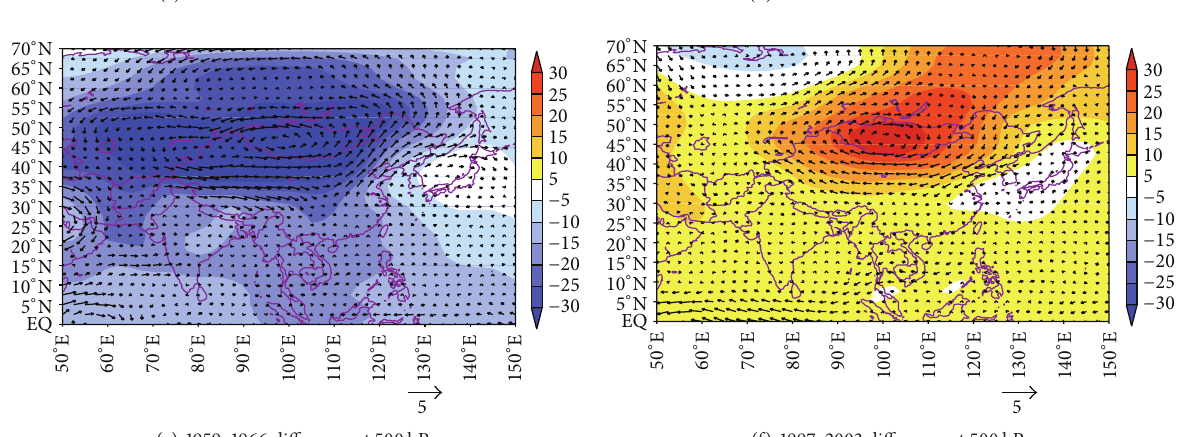
Figure 9: The mean and difference of the geopotential height and wind field at 850 hPa and 500 hPa in East Asia during the summer. The shading indicates the geopotential